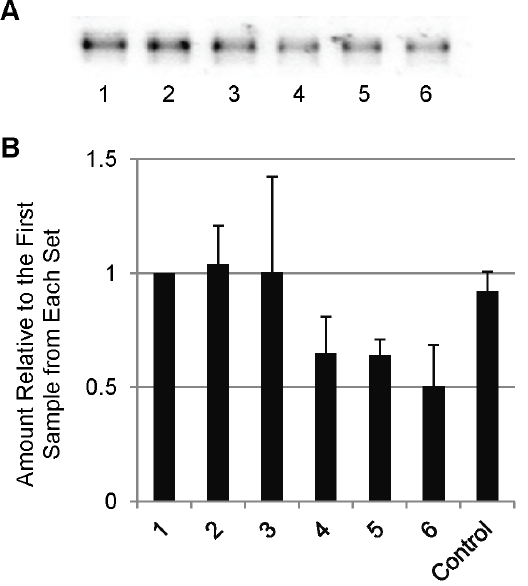
Figure 3. Adsorption of SP-D to Polypropylene Pipet Tips. 5 m l aliquots were taken from a serially aspirated/dispensed solution of SP-D after each round of pipetting, analyzed by Western blot (representative blot shown in A), and quantified using ImageJ software (B). The control consisted of 6 aliquots taken without pipetting. The means were found to be significantly different by One-way ANOVA (p=0.044).